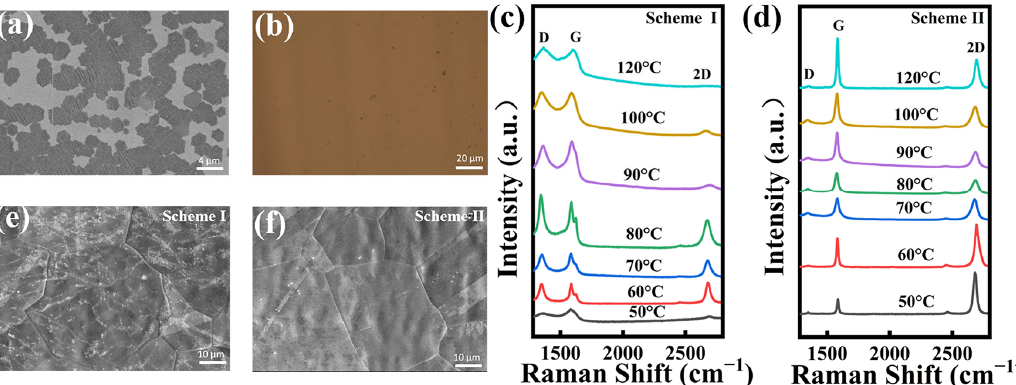
Figure 2. ( a ) SEM images of NG films on the copper surface after CVD growth for 0.5 min. ( b ) Optical image of a typical NG film after CVD growth for three minutes transferred to SiO 2 /Si. Raman spectra of NG films synthesized at different sublimation temperatures in the solid source region using ( c ) scheme I and ( d ) scheme II, respectively. SEM images of NG films grown for 3 min using ( e ) scheme I and ( f ) scheme II, respectively.